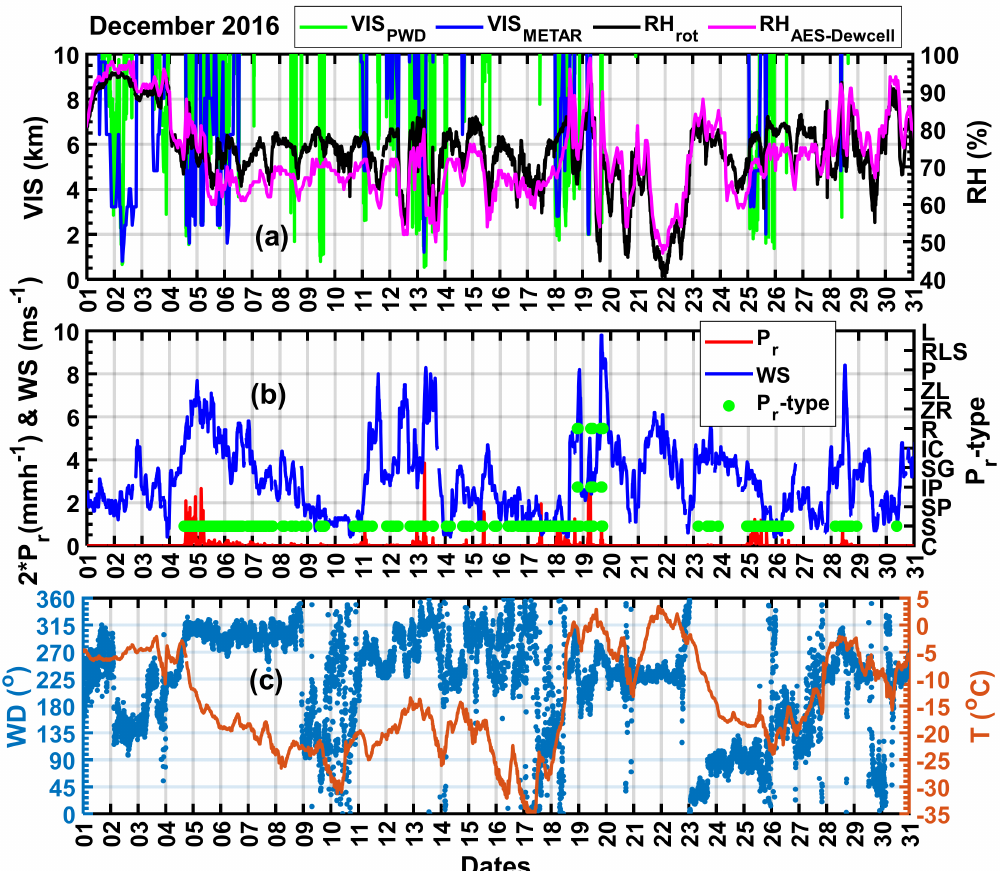
Figure 3. The same as Figure 2, but for the December